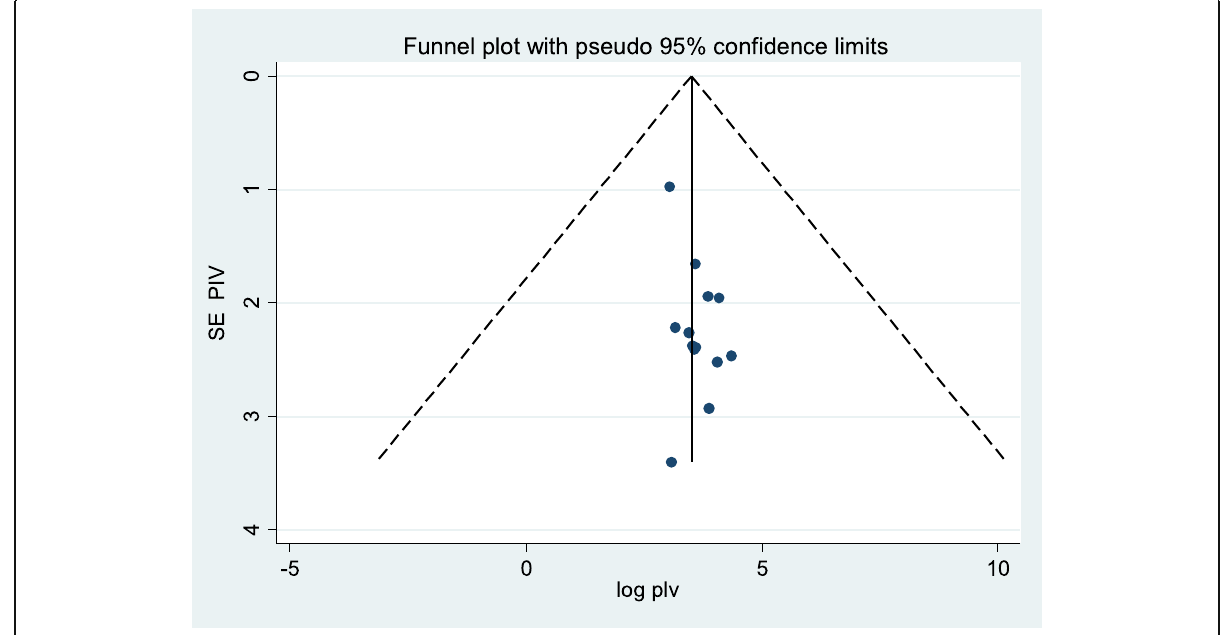
Fig. 5 Funnel plot test for publication bias,